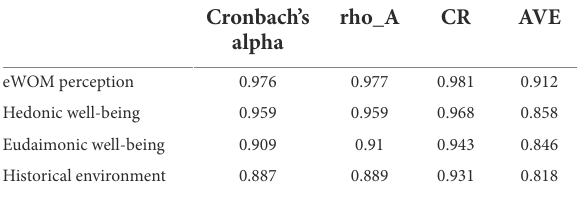
TABLE 9 Study 2: The facet reliability and validity of each variable (historical environment).